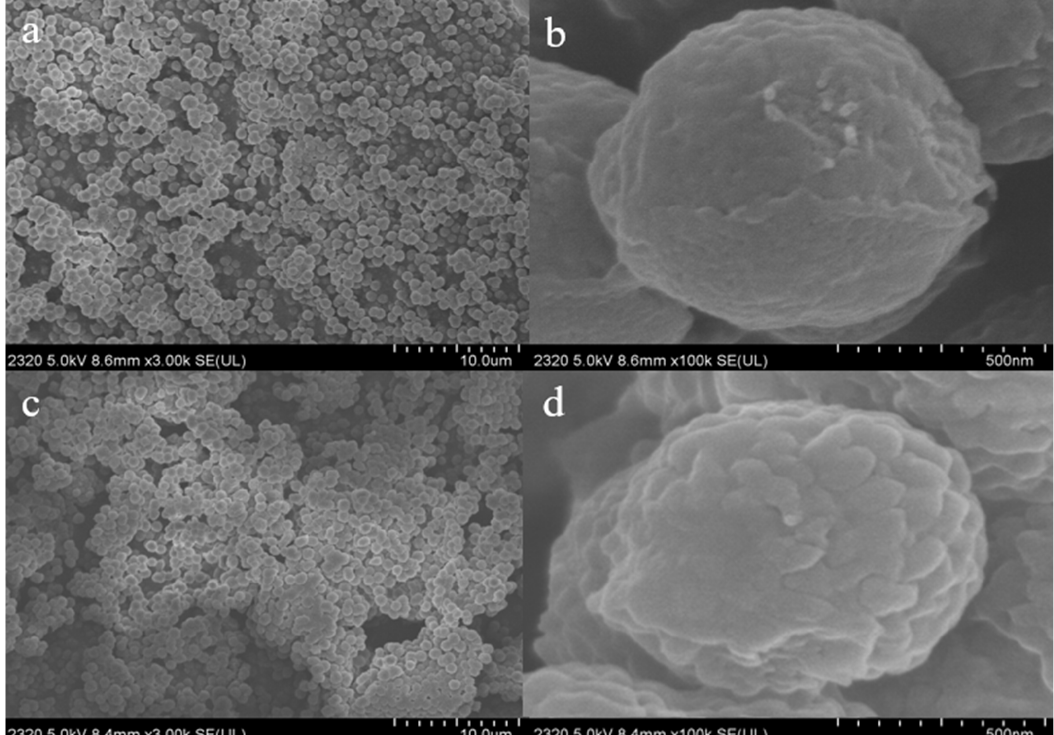
Figure 2. SEM images Cd-I-MA- co -AN before elution ( a , b ) and Cd-I-MA- co -AN after elution ( c , d ).